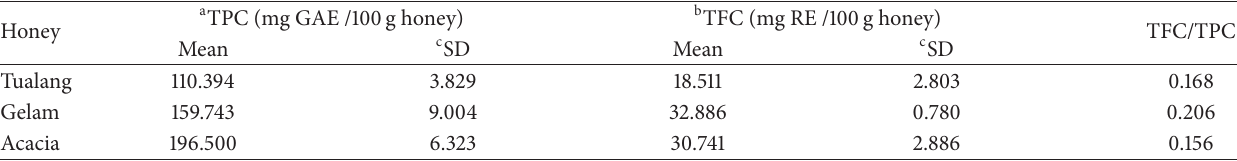
Table 1: Total phenols and total flavonoids in honey samples.